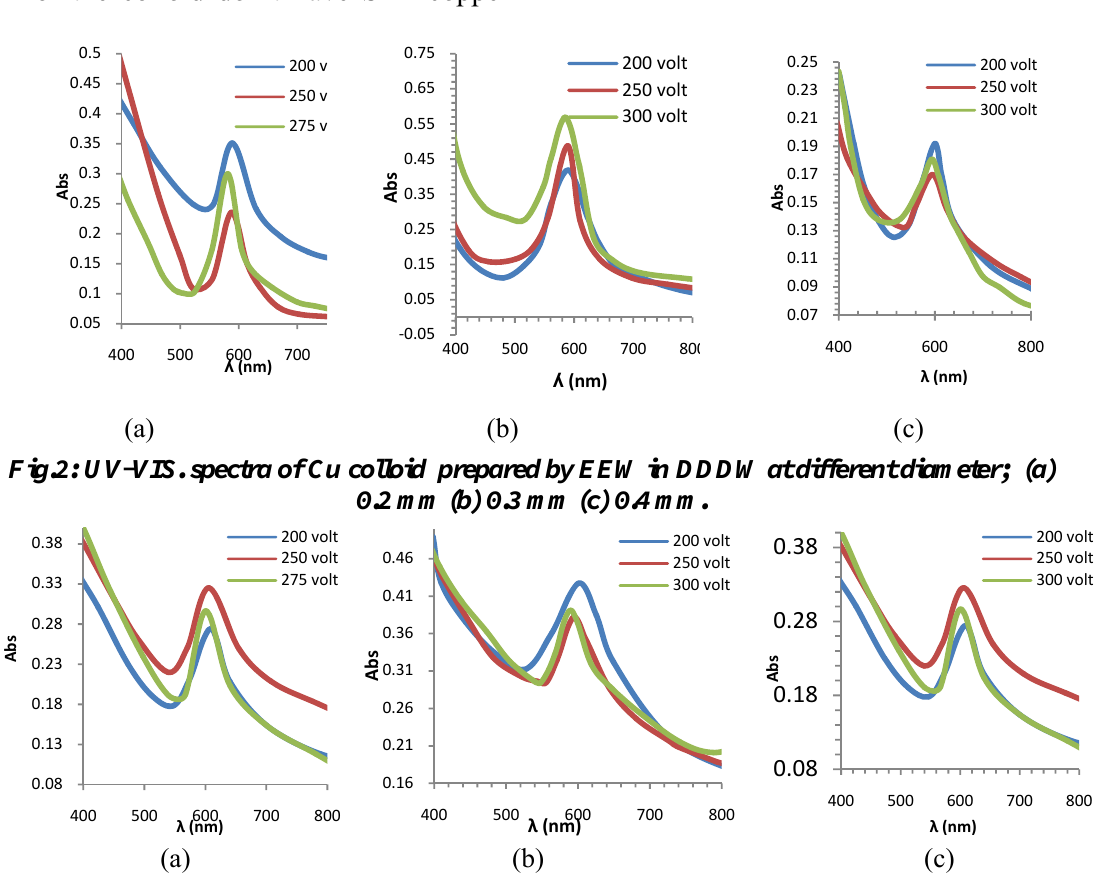
Fig.3: UV-VIS. spectra of Cu colloid prepared by EEW in ethylene glycol at different